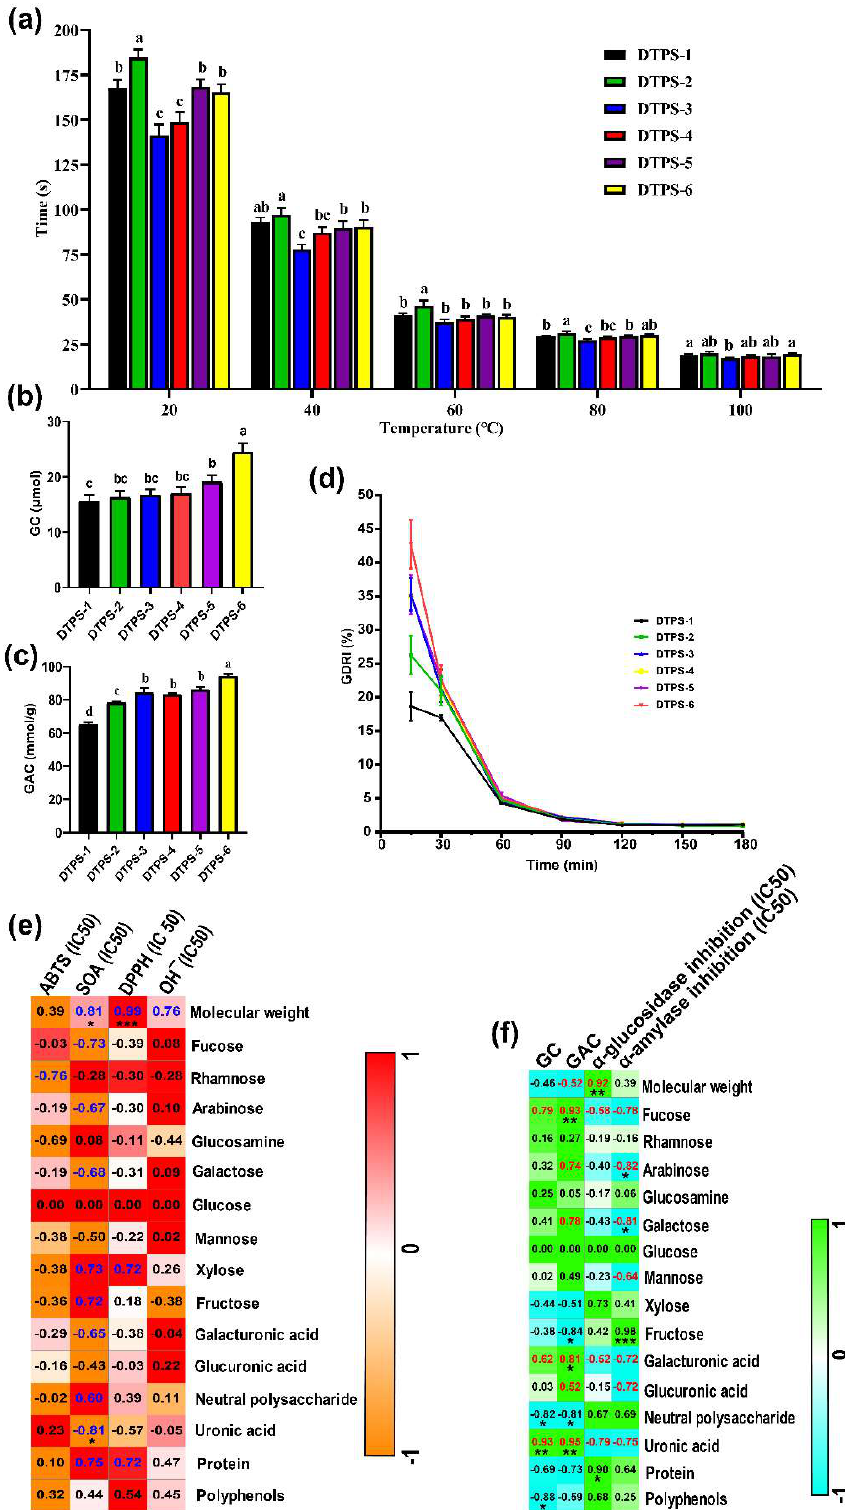
Figure 6. Solubility ( a ), GC ( b ), GAC ( c ), GDRI ( d ), heat map of correlation analysis between the chemical composition and antioxidant activities ( e ), and heat map of the correlation analysis between the chemical composition and hypoglyce- mic activities ( f ). Different letters represent a significant difference among multiple groups. * p < 0.05, ** p < 0.01, and *** p <